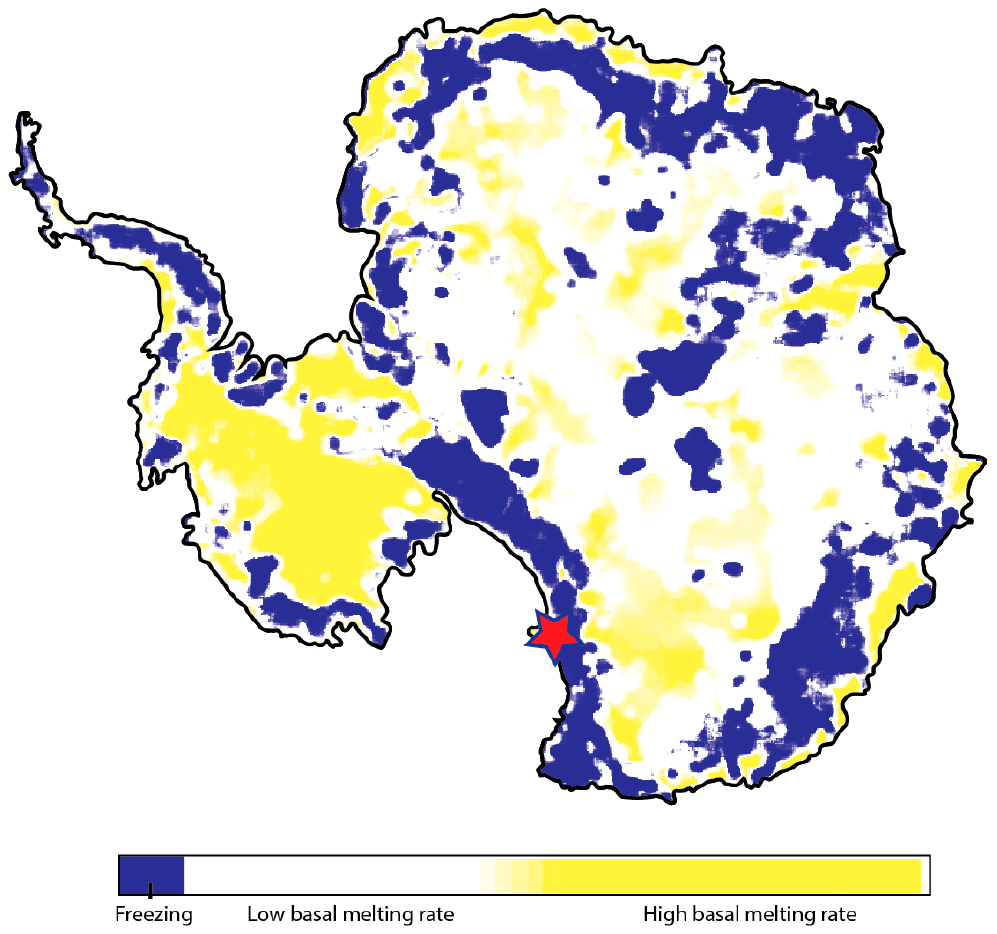
Figure 3. Basal melting conditions in Antarctica, adapted and simplified from Reference [33]. Freezing conditions at the base are indicated by blue and high (above average) melting rates ( < 6 mm / year) are indicated by yellow. West Antarctica has relatively overall basal melt rates, while East Antarctica has lower melts rates. The margin of the East Antarctic ice sheet contains extensive zones of net freezing, and this ‘confining ring’ is proposed by us to be a zone of cryoconcentration near the coast. The red star marks the study area.